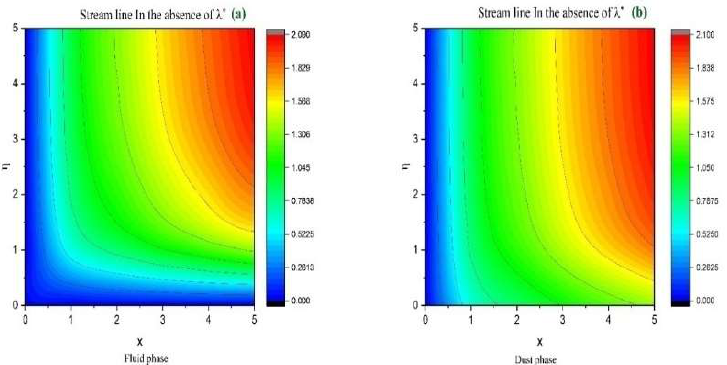
Figure 9. Streamline representation for ( a ) the fluid phase and ( b ) the dust phase in the absence of λ ∗ .